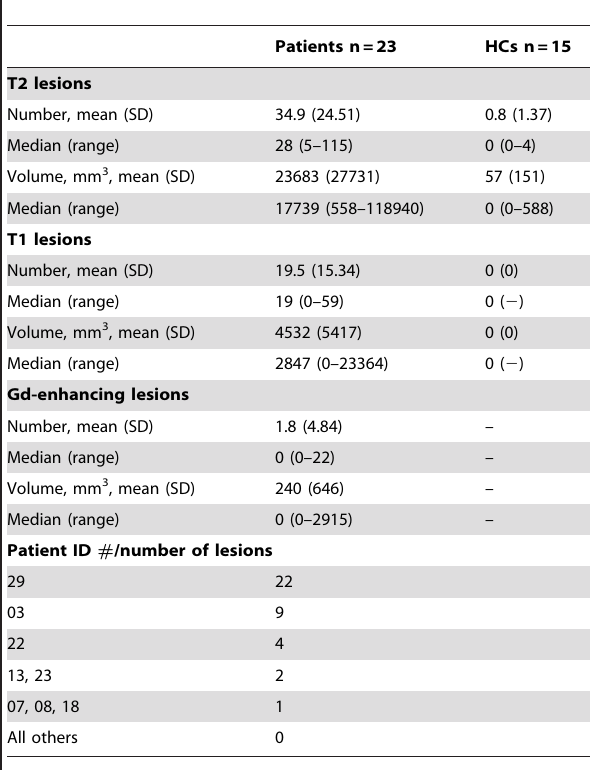
Table 2. Baseline MRI T2, T1 and Gd-enhancing lesion